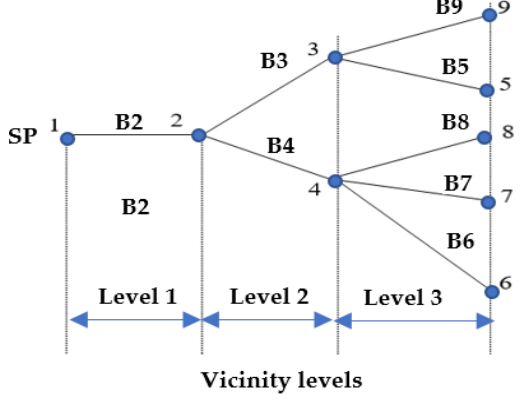
Figure 3. Grouping the branches into vicinity levels.